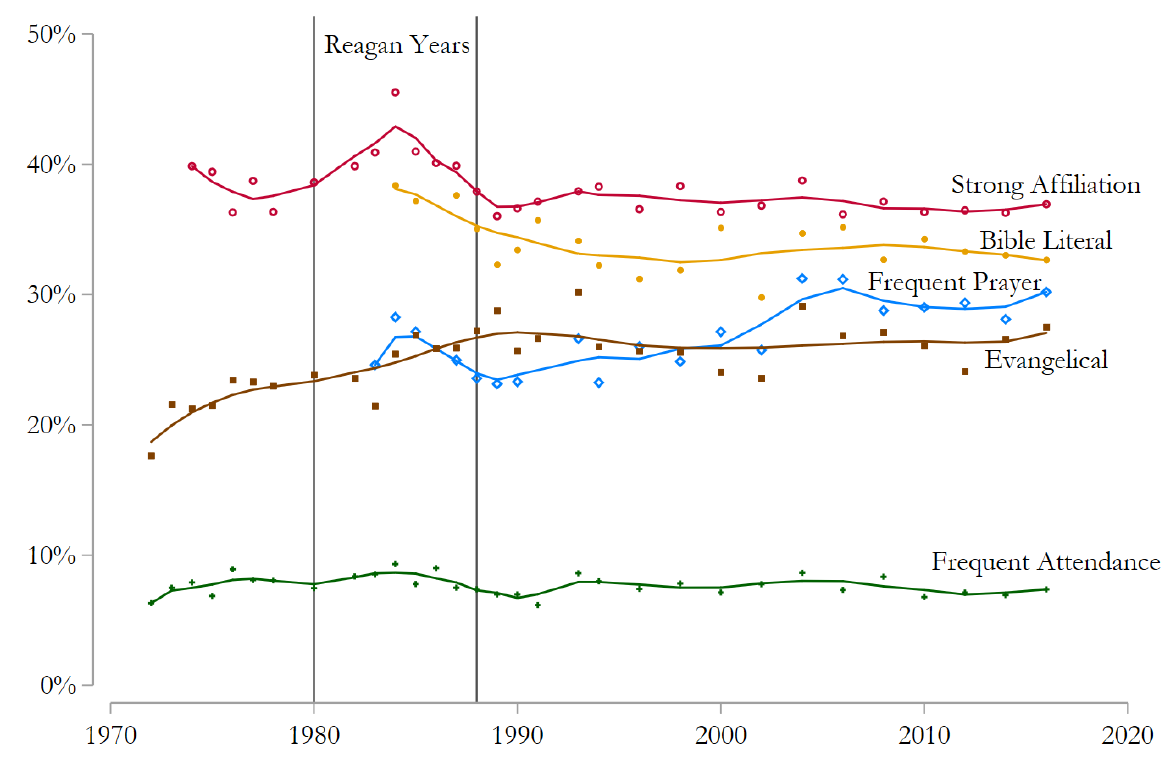
Figure 1: Intense religion by survey year with locally weighted regression lines, General Social